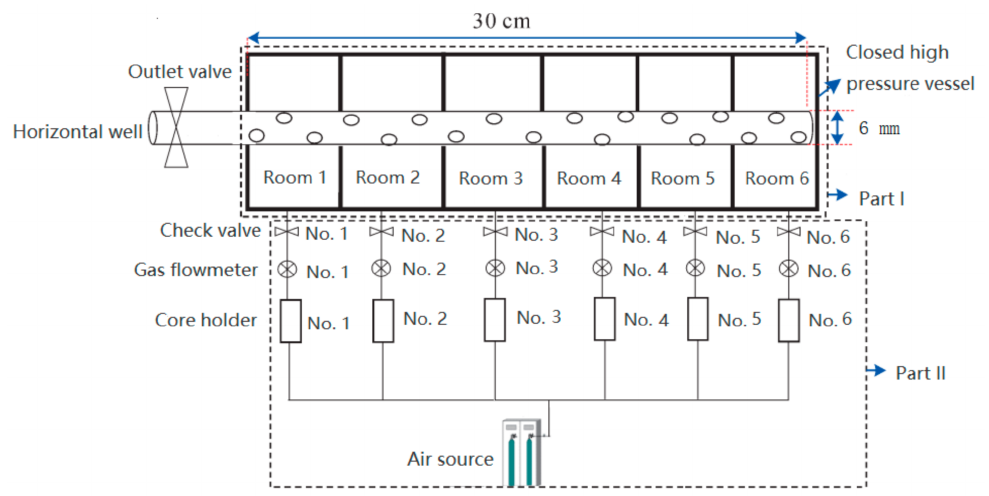
Figure 1. Schematic diagram of the testing device for the gas production profile of a horizontal well. Table 3. Experimental scheme